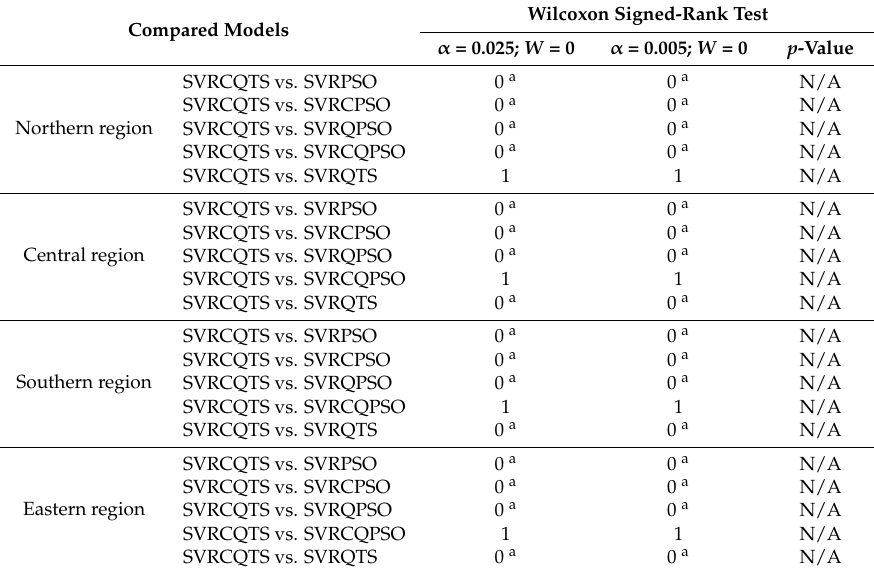
Table 3. Wilcoxon signed-rank test (example